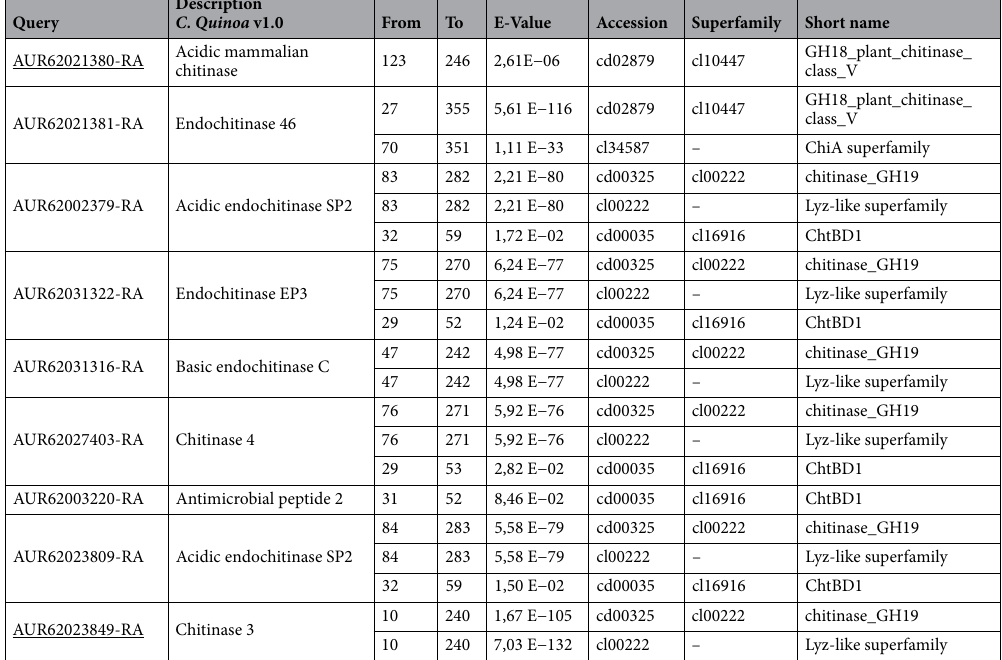
Table 2. Results from NCBI Batch Web CD-search tool for protein domain prediction and C. quinoa v1.0 annotation from Phytozome13 (From…to: range of amino acids in the query protein sequence to which the domain model aligns; E-Value: expected value, the statistical significance of the hit as the likelihood the hit was found by chance; Accession: accession number of the hit, cd = conserved domain from NCBI, cl = superfamily cluster; Superfamily: specific accession number of the superfamily to which the domain model belongs; Short name: defining name for the conserved domain). Underlined AUR codes show chitinase-related proteins exclusively identified in seeds harvested from rainfed